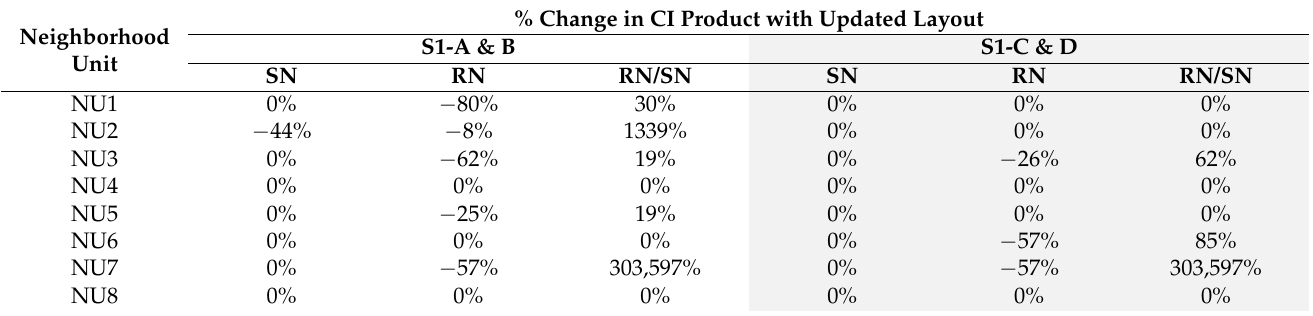
Table 3. Percentage change in CI product with updated C 1 layout as compared to original layout.